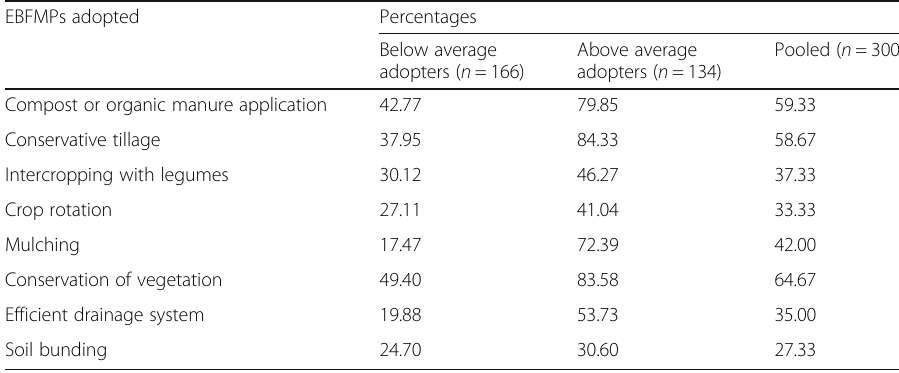
EBFMPs adopted Percentages